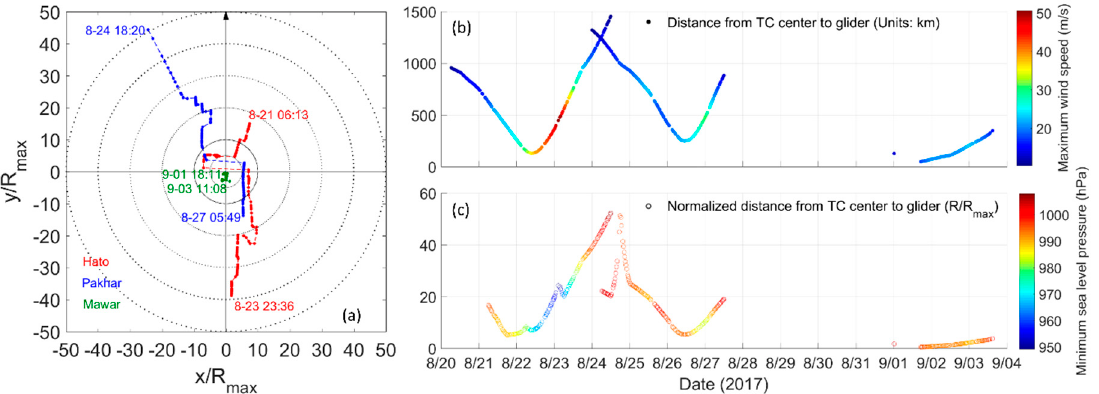
Figure 2. ( a ) Relative position of the wave glider in the moving coordinated system with the origin at the typhoon center and the y-axis in the typhoon’s propagation direction (tropical cyclone (TC) wind speed larger than 17.2 m / s). The coordinates are scaled by the maximum wind speed radius R max ; ( b ) Distance from TC center to the wave glider (units: km). The color depicts the TC maximum wind speed (units: m / s) at radius R max . ( c ) Normalized distance from TC center to the wave glider (units: 1) scaled by the radius of the maximum wind speed. The color depicts the TC minimum sea level pressure (units: hPa).